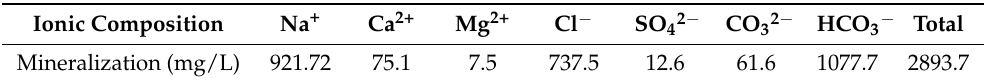
Table 2. Water quality